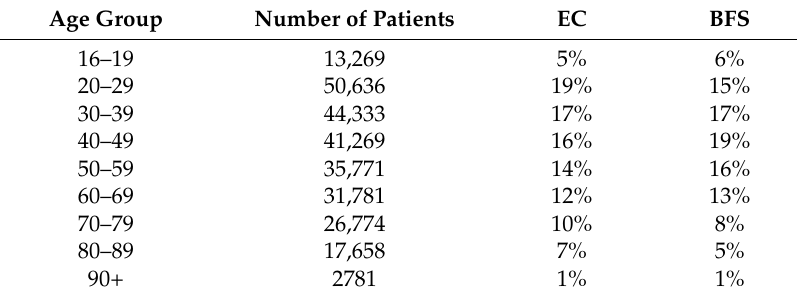
Table 2. Absolute numbers of patients over ten years, by age group (years).